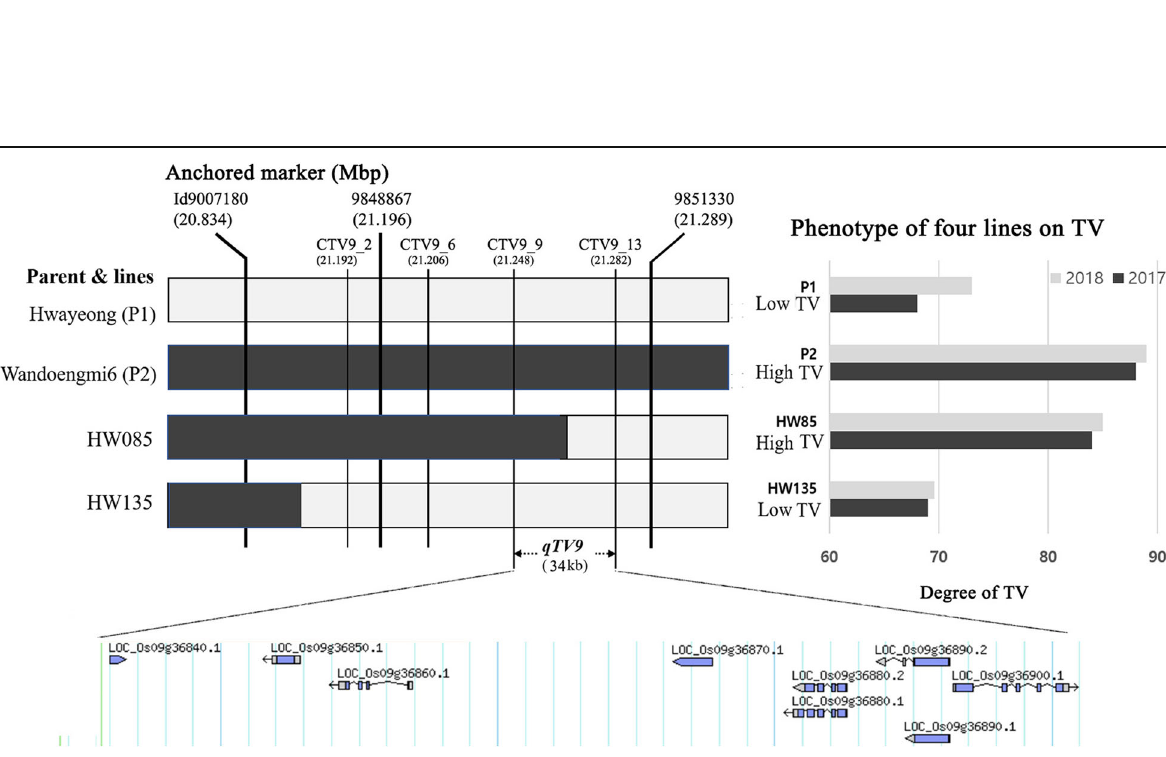
Fig. 4 Identification of the target region for the taste value of cooked rice using graphical dissection of the two recombinant lines HW85 and HW135. White and black bars on the graph indicate allele patterns derived from Hwayeong and Wandoaengmi6, respectively. The left graph shows the degrees of the taste value on parents and selected two recombinants. P2 and HW85 showed the same phenotype with relatively high degrees, and P1 and HW135 had low